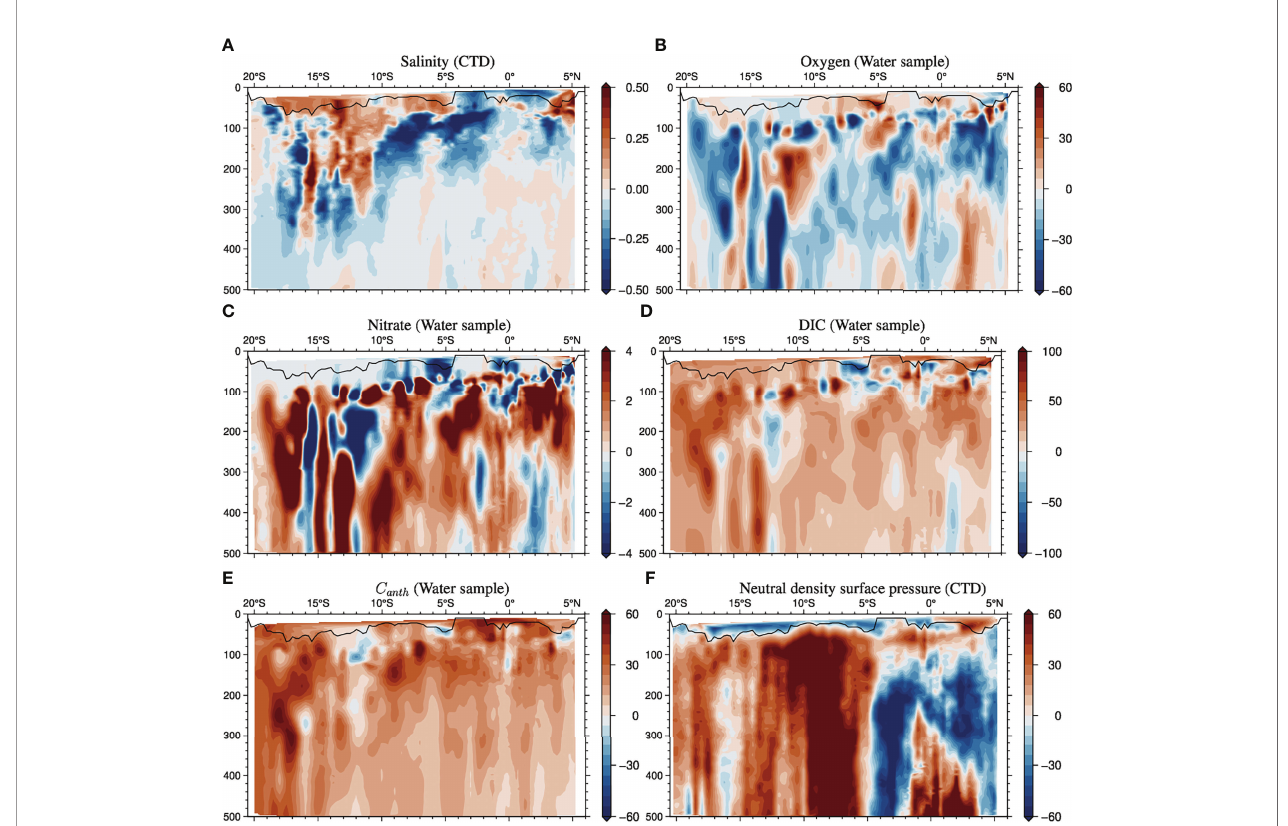
FIGURE 14 | Same as Figure 3 except for the changes from March 1995 to December 2019, changes in salinity (A) , DO (B) , DIC (C) , anthropogenic carbon (D) , and isopycnal depth (F)